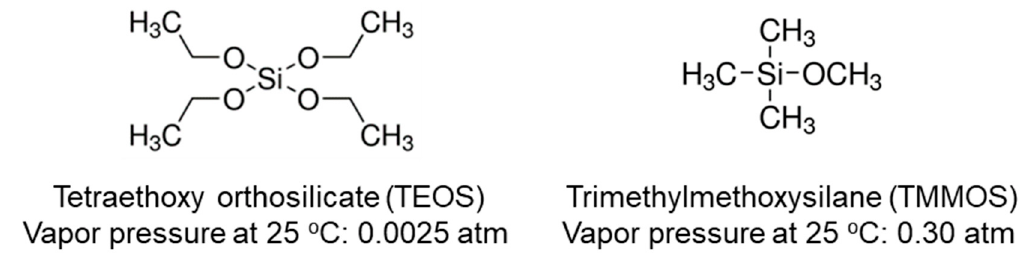
Figure 1. Chemical structures and vapor pressures of tetraethoxy orthosilicate (TEOS) and trimethylmethoxysilane